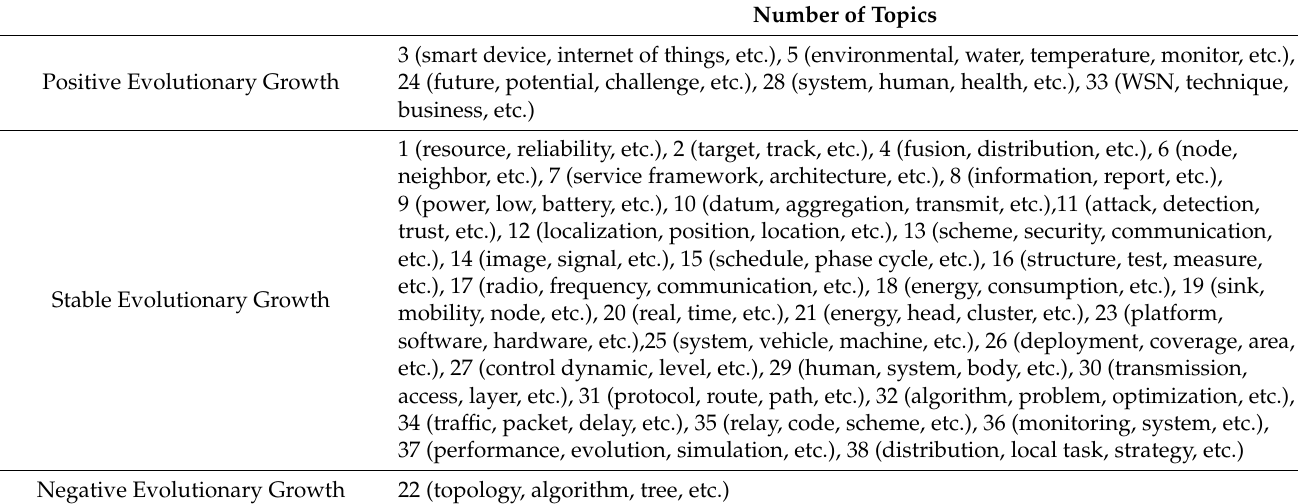
Table 4. Dynamics of trends in wireless sensor networks using trend analysis.